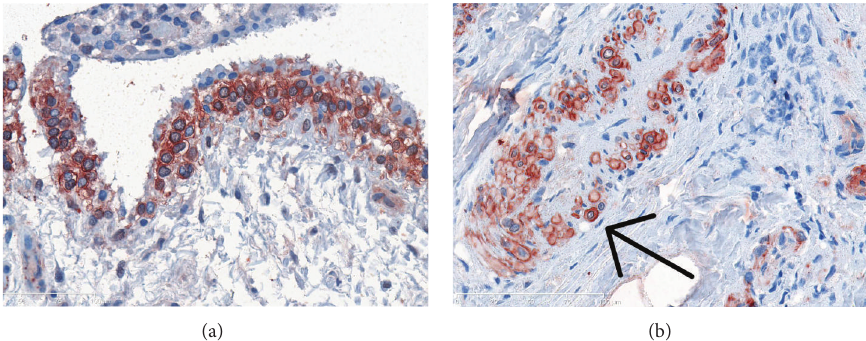
Figure 2: OSCAR positive cells (red) in synovial tissue. (a) OSCAR immunostaining in the lining cells of OA tissues. (b) Mononuclear OSCAR positive cells as indicated by arrow. The magnification was 400x.